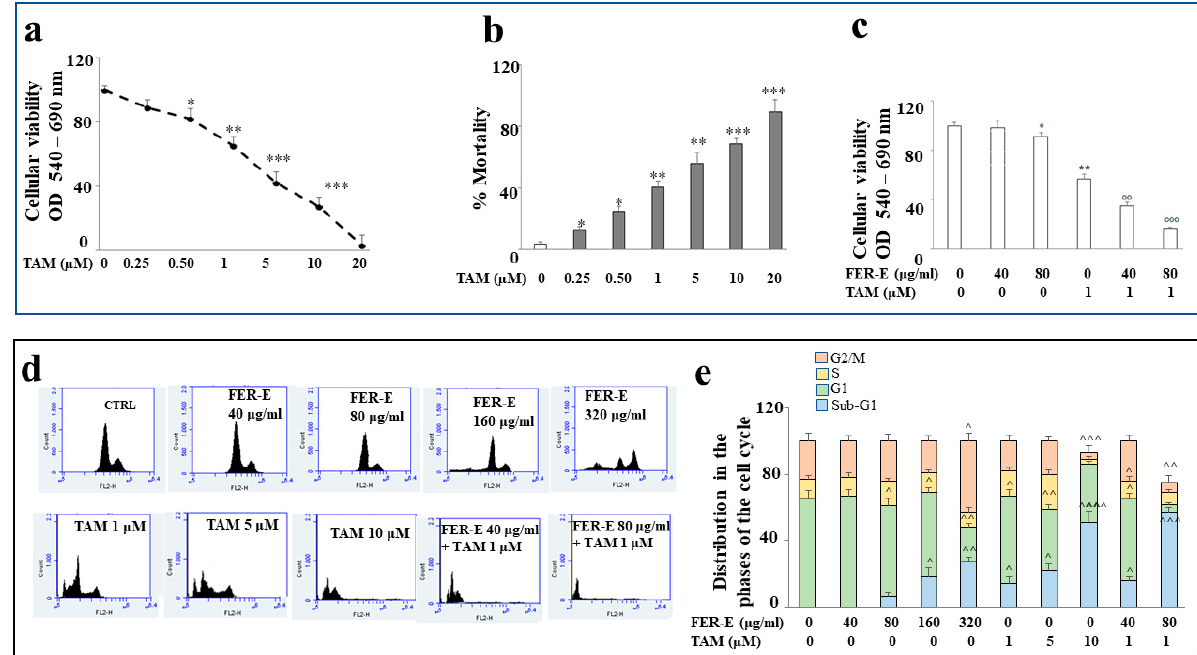
Figure 5. Additive effect of FER-E + TAM on MCF-7 cells. In ( a ) a dose–response curve of viability of MCF-7 cells, treated with increasing concentrations of TAM and measured through the MTT test, is shown. The spectrophotometric reading of the MTT test comprises values between 0 and 100, where 0 is considered to be the minimum viability and 100 the maximum. In ( b ) the same experiments were evaluated by Trypan blue exclusion assay mortality test. Both methods gave the same results. In ( c ) the results of the changes of viability, induced by the co-treatment FER-E + TAM, were highlighted. In this case, the MTT test was accompanied by cell cycle assessment ( d ), which confirmed the outcome of the experiment. In ( e ) the quantification of cellular cycle is highlighted. Three independent experiments were carried out, and the values are expressed as the mean ± sd. * denotes p < 0.05 vs. the control; ** denotes p < 0.01 vs. the control; *** denotes p < 0.001 vs. the control. °° denotes p < 0.01 vs. TAM 1 µM. °°° denotes p < 0.001 vs. TAM 1 µM. ^ denotes p < 0.05 vs. relative phase of the control. ^^ denotes p < 0.01 vs. relative phase of the control. ^^^ denotes p < 0.001 vs. relative phase of the control. Analysis of Variance (ANOVA) was followed by a Tukey–Kramer comparison test.